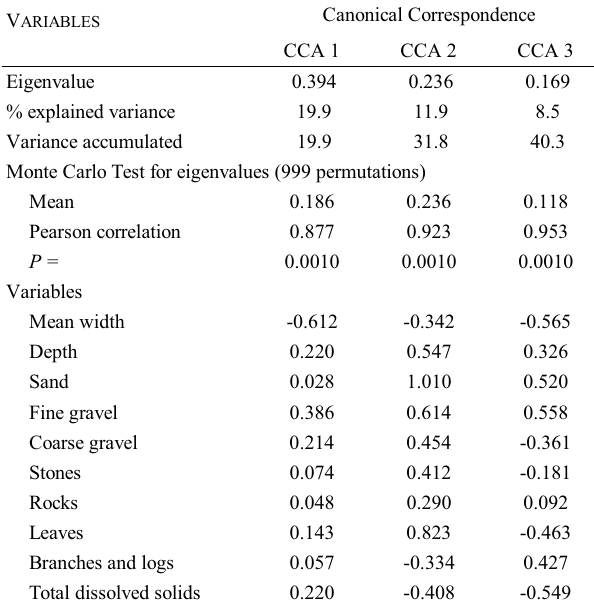
Table 3 . Canonical correspondence values and percent ex- plained variance associated with the first three axes for habi- tat and substrate variables measured.